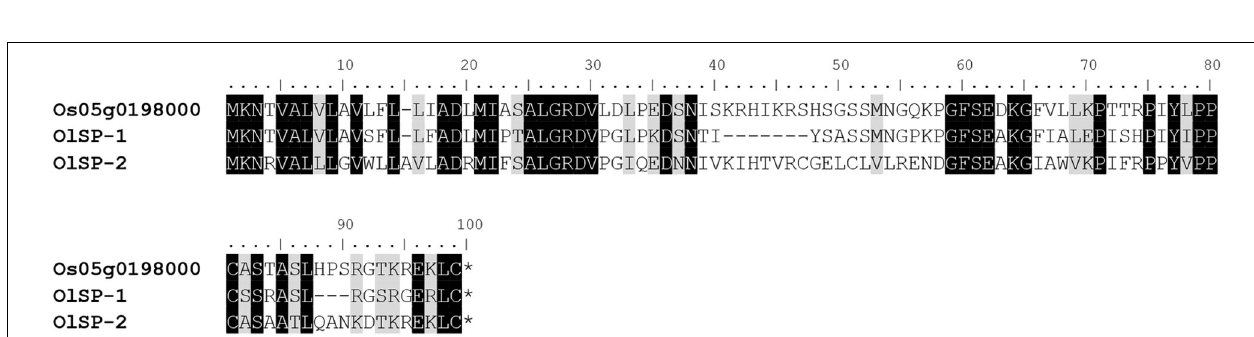
Frontiers in Plant Science |